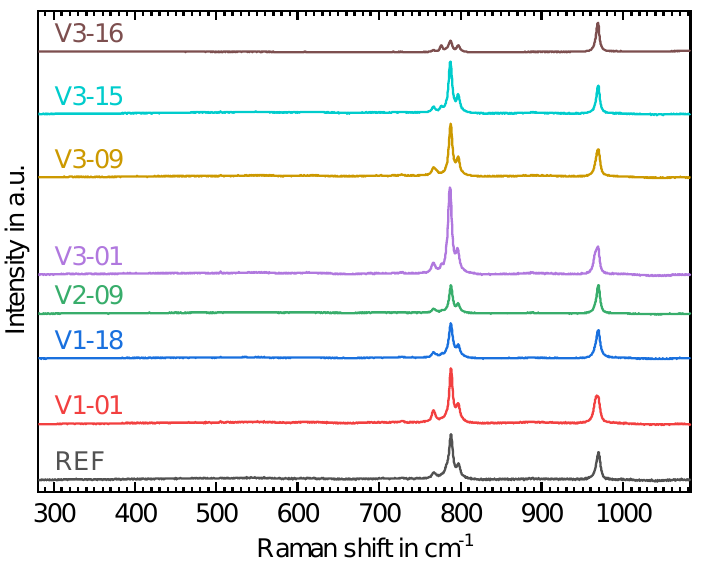
Figure 17. Raman spectra of eight selected sample fields of machined 6H-SiC. Due to the unit cell c- and a-axis correlation (see Figure 1) to the LO and TO mode, respectively, their ratios (LO/TO) are a measure for the SiC grain orientation [36,37] which is random in the case of polycrystalline SiC. The peaks at 797 cm − 1 are associated with 3C- and 4H-SiC polytypes and hence serve as an indicator for the presence of stacking faults (SF) in 6H- SiC. A higher TO SF /TO ratio (given in Table 6) therefore suggests more machining-induced defects in the respective material. Furthermore, a shift of the TO and LO peak positions may indicate residual stress in the excited material. Values calculated for LO according to the model of Liu and Vohra[38] are listed in Table 6. These calculated values are best for the REF field whereas V1-01, V3-01 and V3-16 exhibit the highest signs of SF generation and residual stress. In all eight sets of parameters, no machining-induced amorphization occurs, which would be indicated by a significant broadening of the Raman spectra